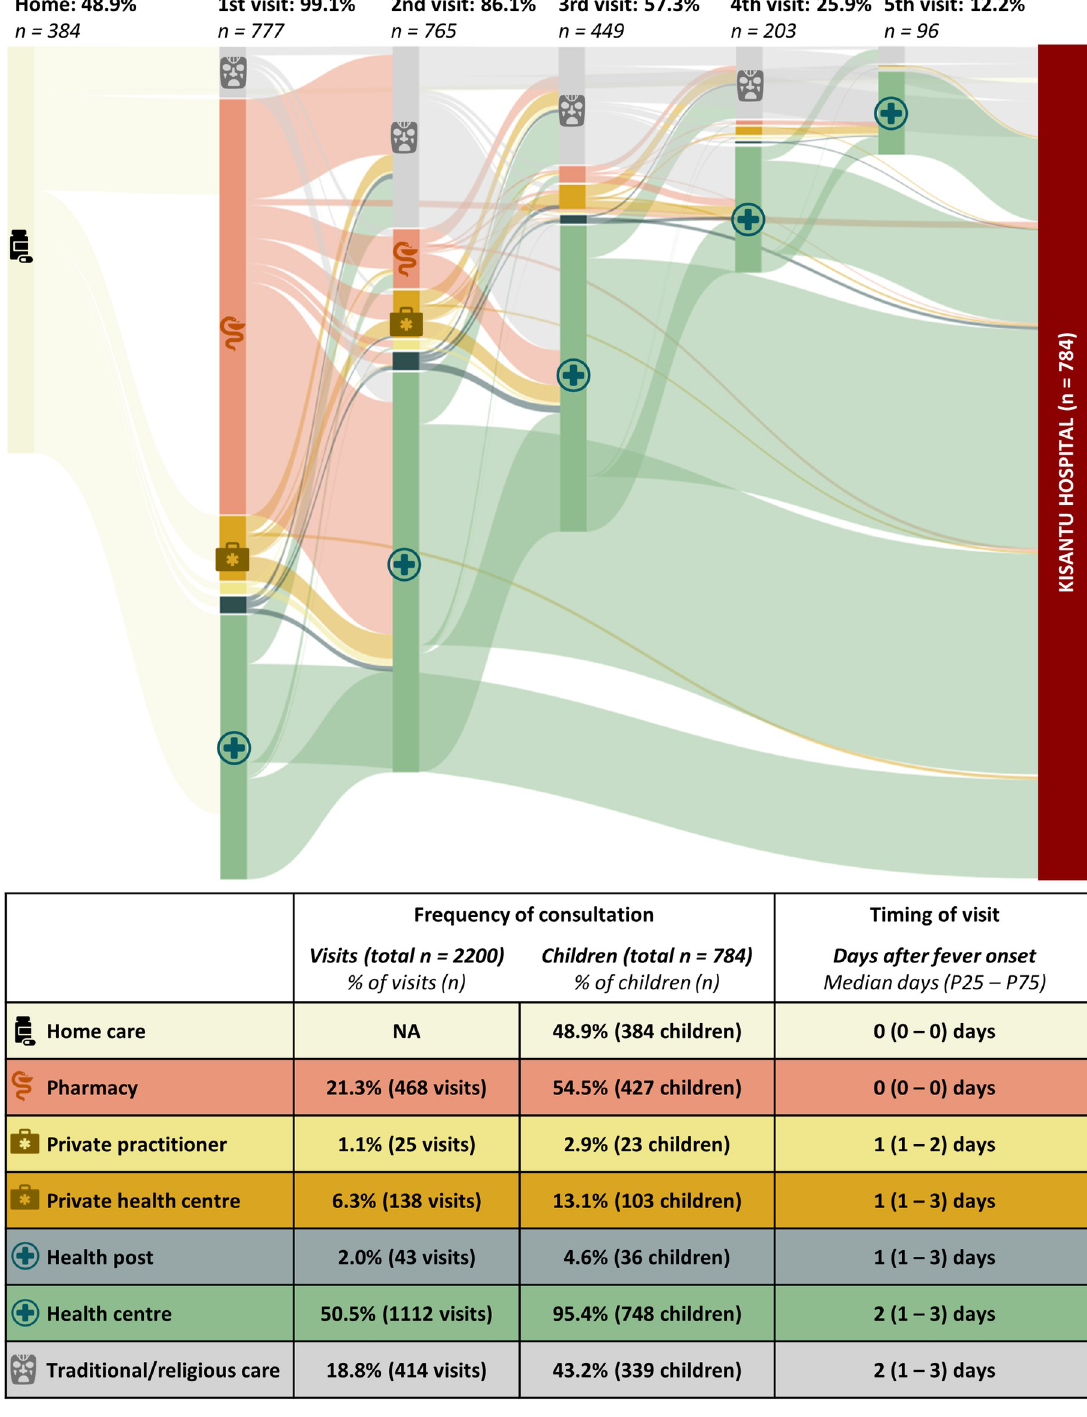
PLOS NeglectedTropical Diseases | https://doi.org/10.1371/journal.pntd.0011156 March 6,